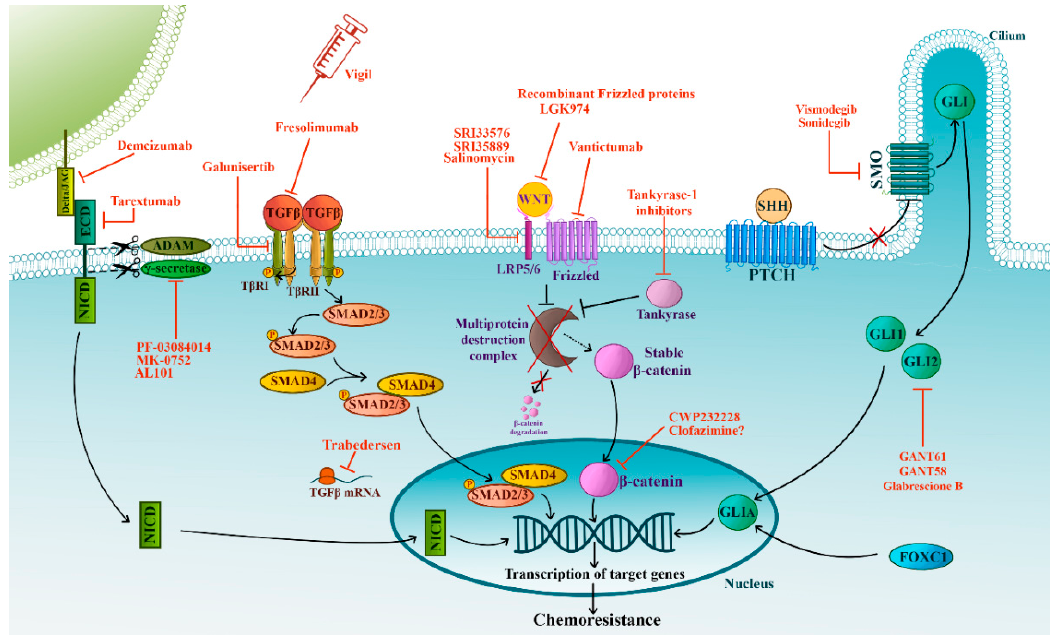
Figure 2. Overview of developmental pathways and their potential inhibitors in triple-negative breast cancer (TNBC). TGF- β (transforming growth factor-beta), Notch, Wnt/ β -catenin and hedgehog (Hh) pathways all have crucial roles in initiation, progression, CSC maintenance, metastasis, and chemoresistance of TNBC. A number of inhibitors have recently been developed to target these pathways. Inhibitors are shown in red.